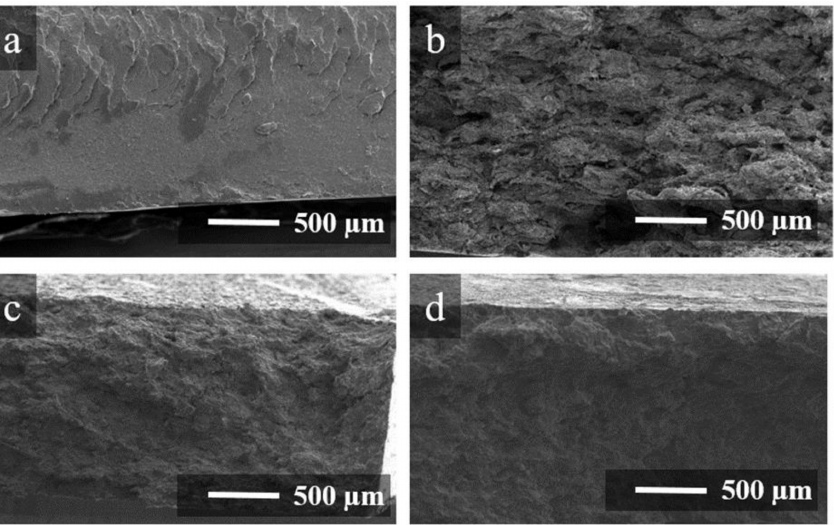
Figure 2. SEM images of brittle fractures of pure (P(VDF-TFE)) ( a ), 1FPC-0 ( b ), 1FPC-50 ( c ), and 1FPC-100 ( d